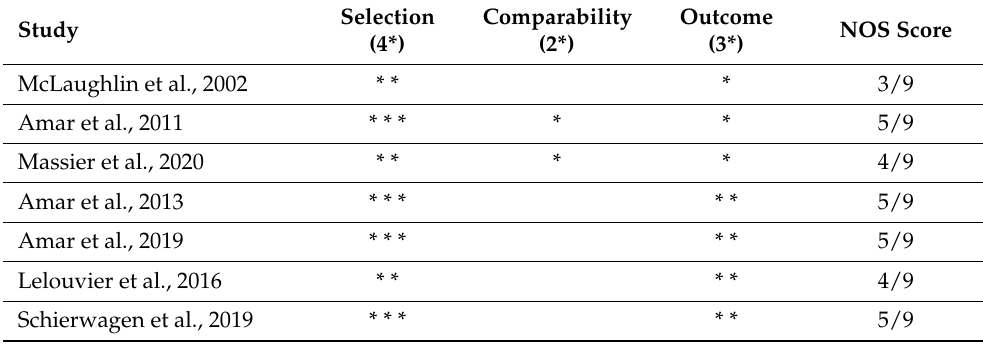
Table 1. Risk of Bias for non-randomized studies according to Newcastle-Ottawa Scale for non- randomized trials.